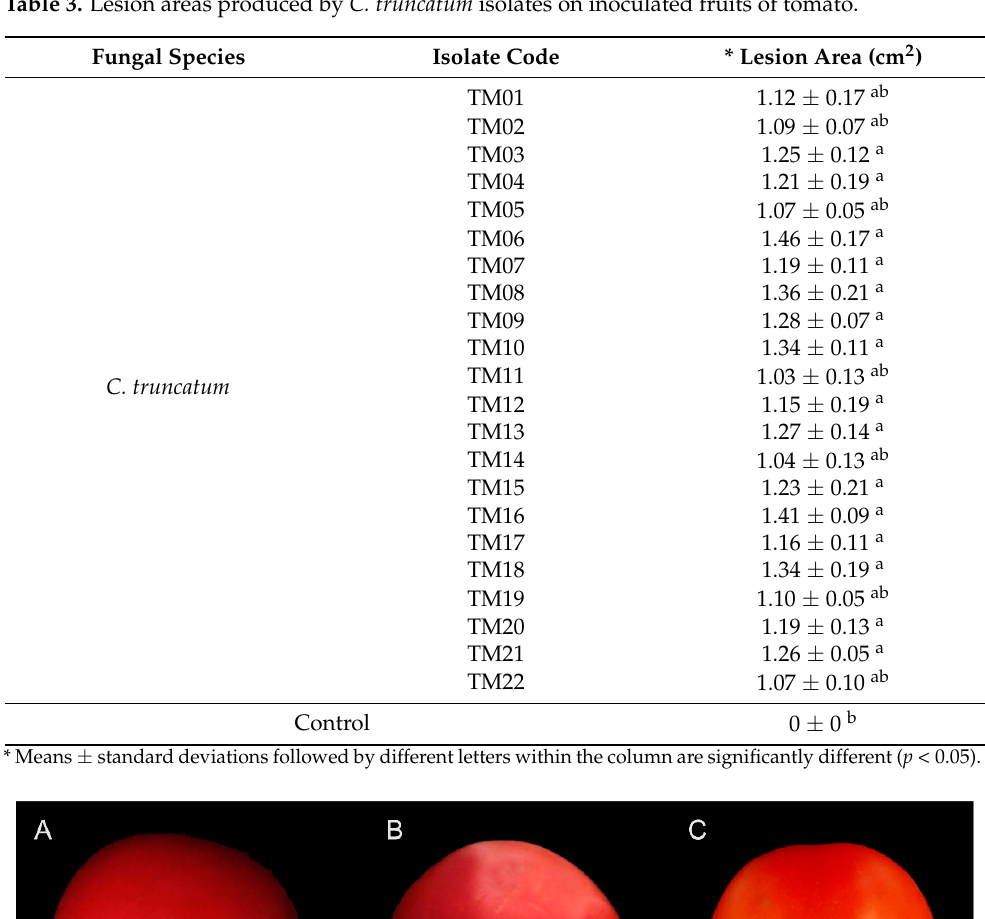
Table 3. Lesion areas produced by C. truncatum isolates on inoculated fruits of tomato. Fungal Species Isolate Code